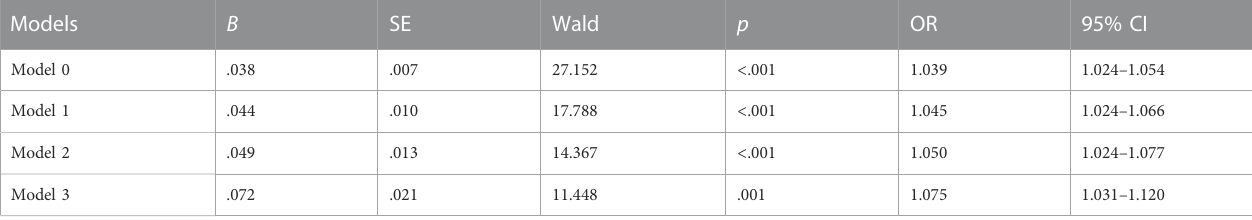
TABLE 5 Multivariable logistic regression analysis to identify the association of the FAR with arterial stiffness in male patients with T2D. Models